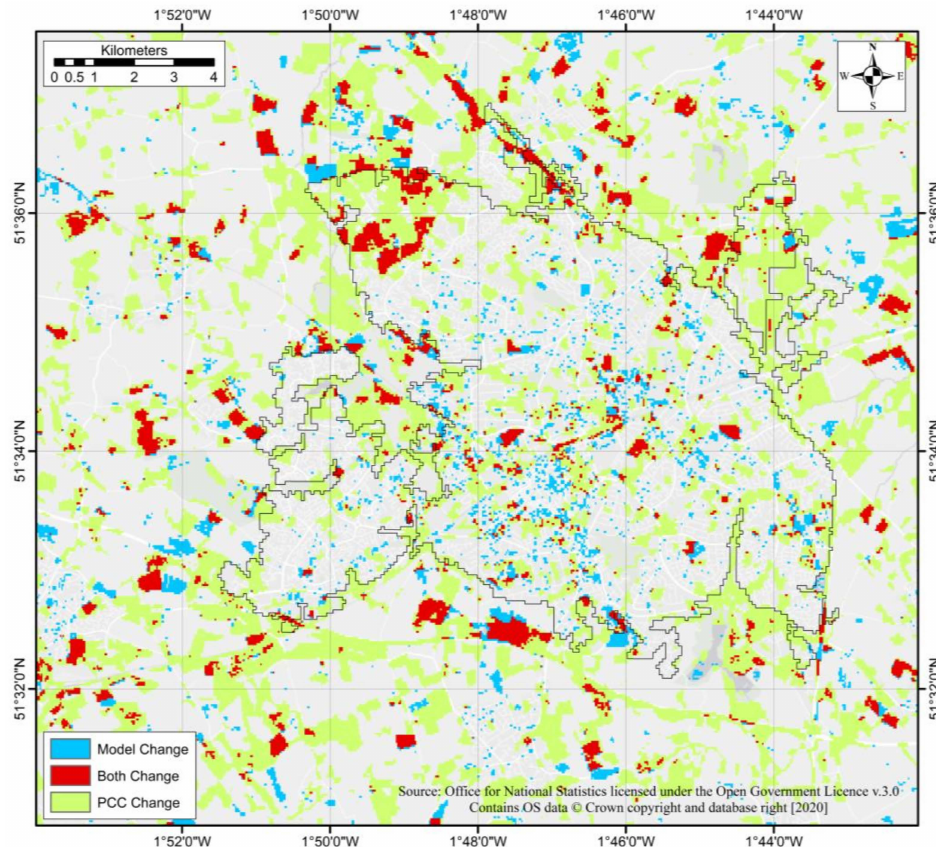
Figure 6. Comparison of the harmonic model output with a PCC land cover map from [35,36]. Uncoloured areas were detected as having undergone no-change in both methods. Grey line represents outline of urban extent as of